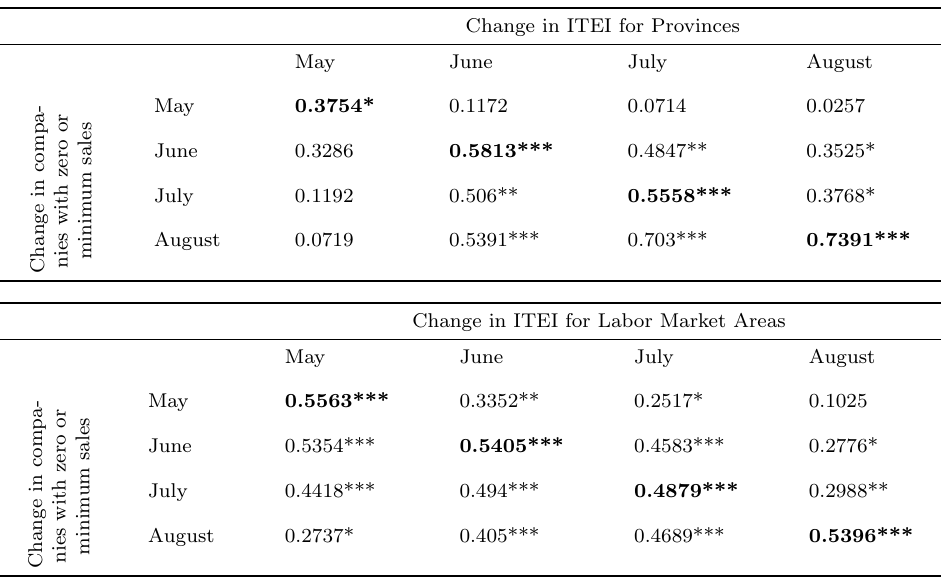
Table 3: Pearson’s correlations between ITEI and companies in a critical situation, measured as percentage changes with respect to